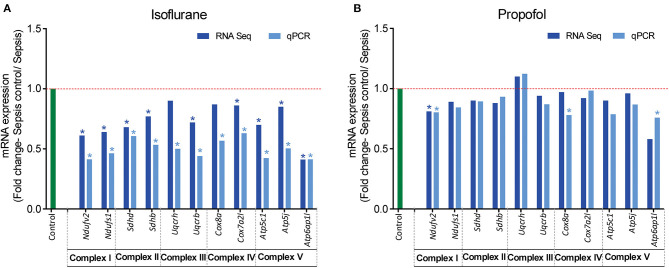
RT-qPCR validation of mitochondrial OXPHOS complex (I-V) genes that showed altered expression in RNASeq analysis. Fold change of gene expression is represented for (A) Isoflurane sepsis, (B) Propofol sepsis. From the RNA-Seq mRNA expression profiles, 2–3 genes with altered expression, encoding in mitochondrial OXPHOS complexes (I-V) were selected and gene expression was verified with RT-qPCR. Isoflurane sepsis effects the expression of all genes representing the 5 mitochondrial oxidative phosphorylation complexes (I-V). All genes represented here are significantly down-regulated compared to normal (9/11 genes show significant difference with both RNASeq and qPCR). However, for Propofol-sepsis group there is no significant change compared to normal, as determined by both mRNA-RNA-Seq and RT-qPCR analysis (only 1/11 genes show significant difference with both methods). The results of RT-qPCR are consistent with those of RNA-Seq mRNA expression profiles. “*” denotes significant (p < 0.05) expression obtained with RT-qPCR and for RNA-Seq it is the FDR adjusted P-value for differential expression. The red dashed line represents the control group fold change level (FC = 1) and green bar represents the RT-qPCR control group.